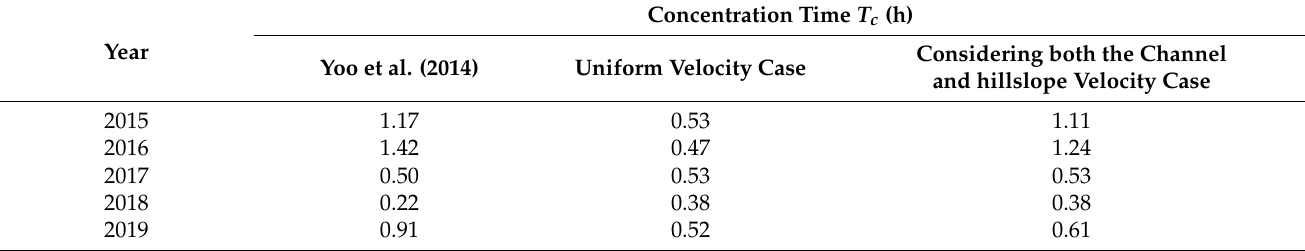
Table 5. Comparison of concentration times estimated differently; one is based on the observed rainfall-runoff analysis using the method by Yoo et al. (2014), another is that for the uniform velocity case, and the third considers both the channel and hillslope velocity